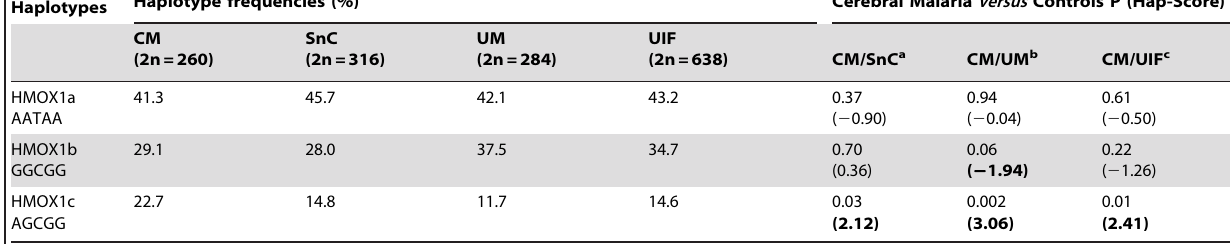
Table 3. Association results for HMOX1 haplotypes.